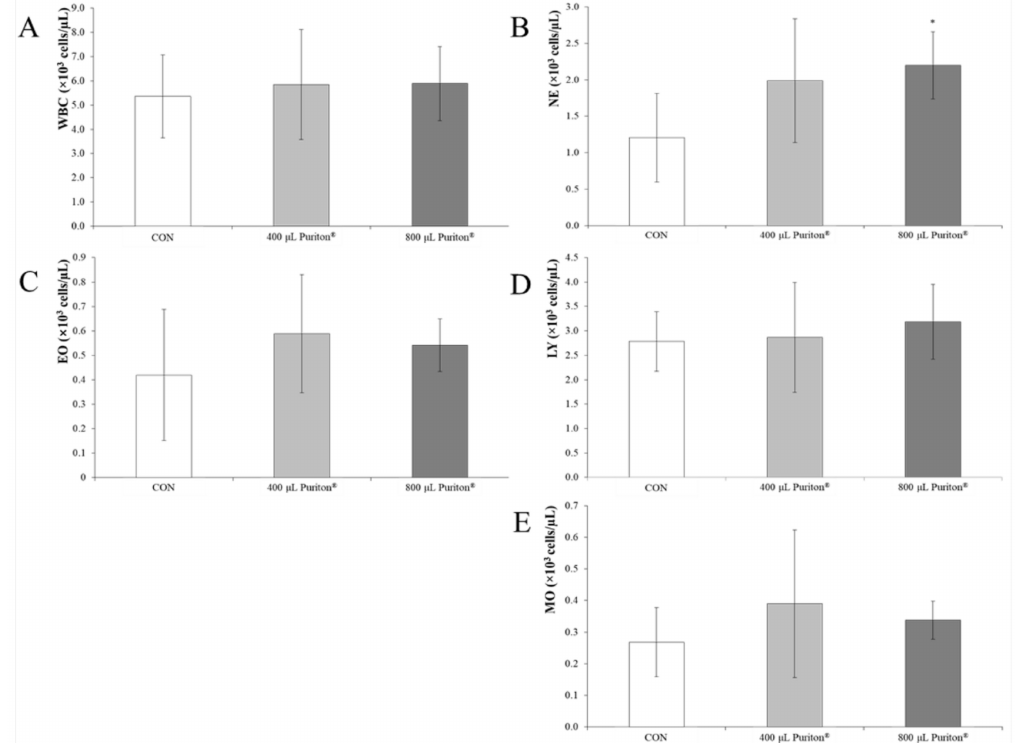
Figure 3. Results of white blood cell and di ff erential cell counts. Puriton ® slightly increased the number of neutrophils. ( A ), the di ff erence of WBCs among the groups; ( B ), the di ff erence of neutrophils among the groups; ( C ), the di ff erence of eosinophils among the groups; ( D ), the di ff erence of lymphocytes among the group; ( E ) the di ff erence of monocyte among the groups. WBC, white blood cell; NE, neutrophil; EO, eosinophil; LY, lymphocyte; MO, monocyte. Each bar represents the mean ± SD (n = 6). * p < 0.05 vs. control (CON)